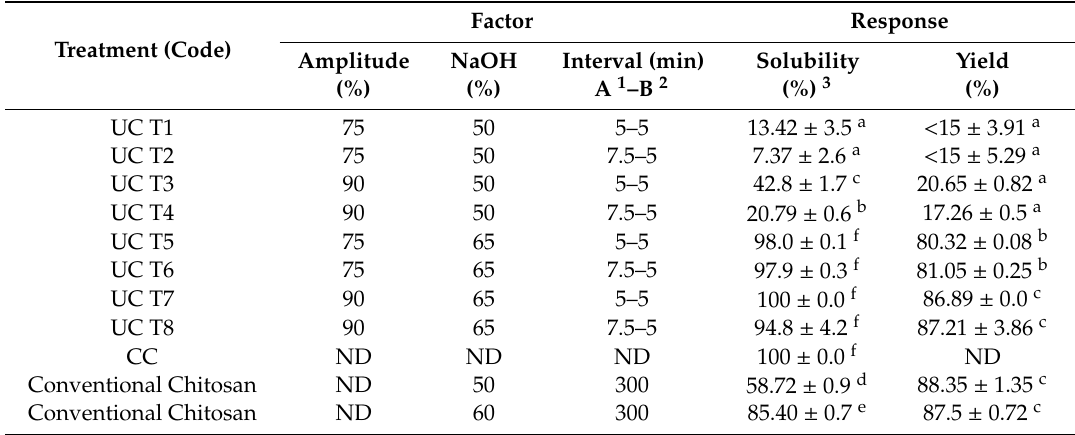
Table 1. Solubility and extraction yield results from the di ff erent biopolymers obtained (partial deacetylated chitin and chitosan) by ultrasound-assisted extraction (UAE) and conventional methods.